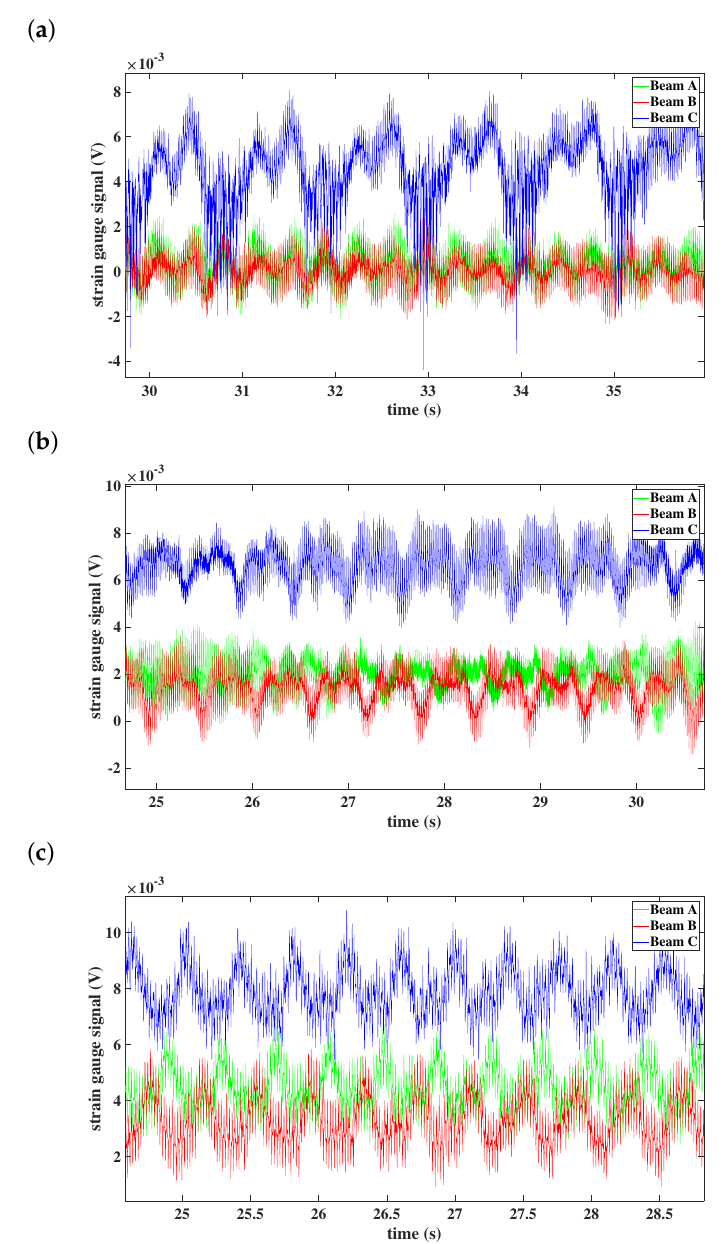
Figure 16. Time histories of individual beams: ( a ) preset angle 0 ◦ and angular speed 50 rpm, ( b ) preset angle 0 ◦ and angular speed 100 rpm, ( c ) preset angle 0 ◦ and angular speed 150